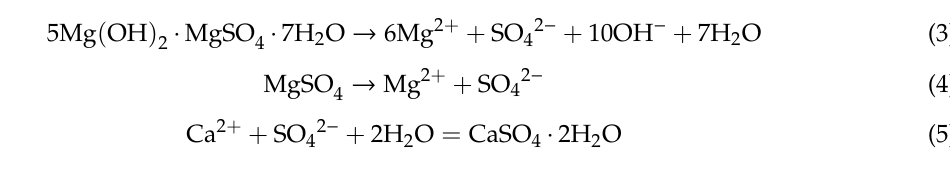
Table 2. Concentrations of Mg 2 + and SO 42 − in di ff erent chloride solutions used to immerse hardened paste for 28